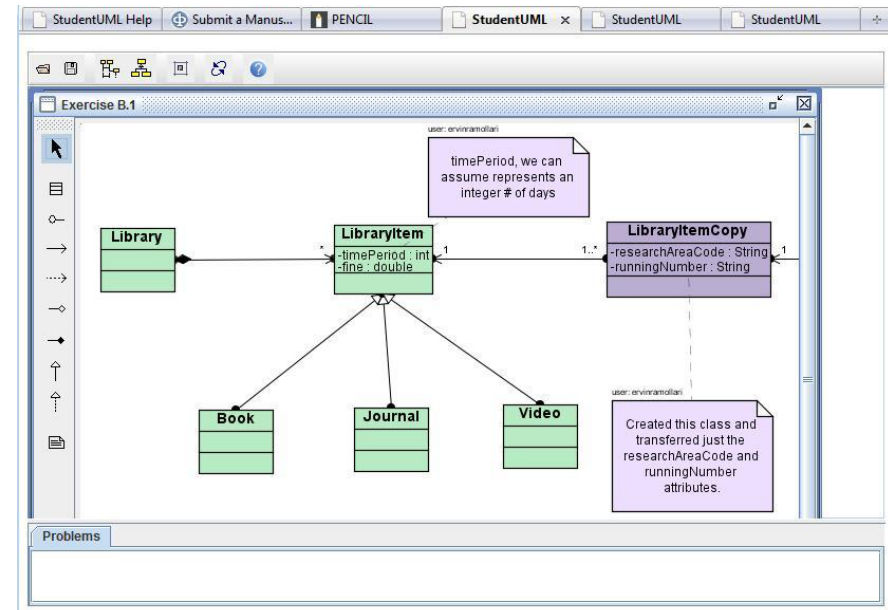
Figure 6. UML elements created by a user are filled with that user’s color while notes are preceded by the user’s PENCIL nickname.